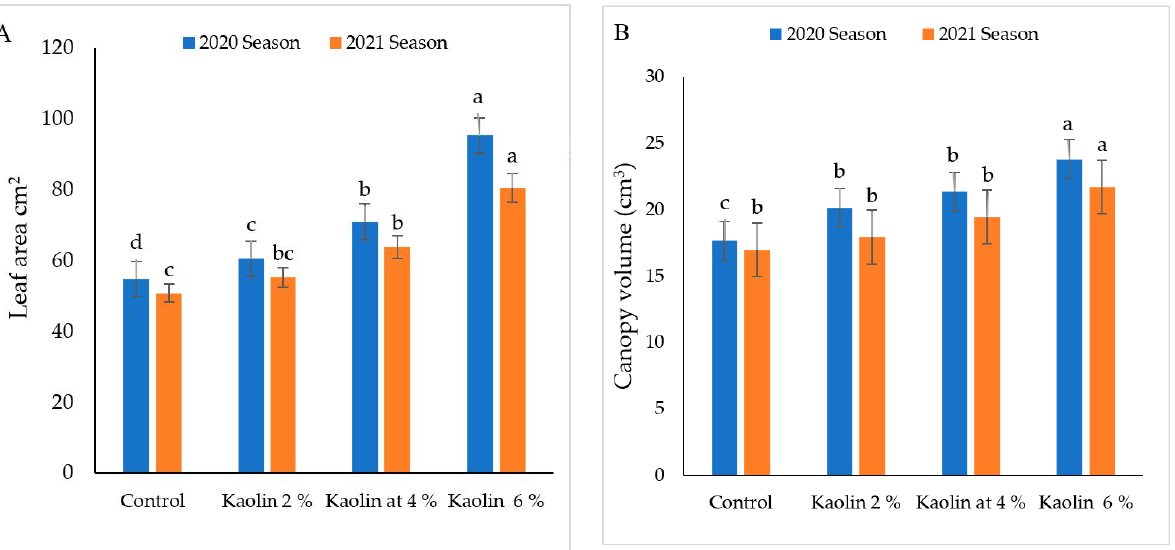
Figure 2. Effect of kaolin spray on: ( A ) leaf area (cm 2 ) and ( B ) canopy volume (cm 3 ) of Keitt mango cultivar during seasons 2020 and 2021. Bars indicate mean values ± SE (n = 9). Different letters above columns indicate significant differences among pruning treatments at p = 0.05 according to Bartlett’s test.